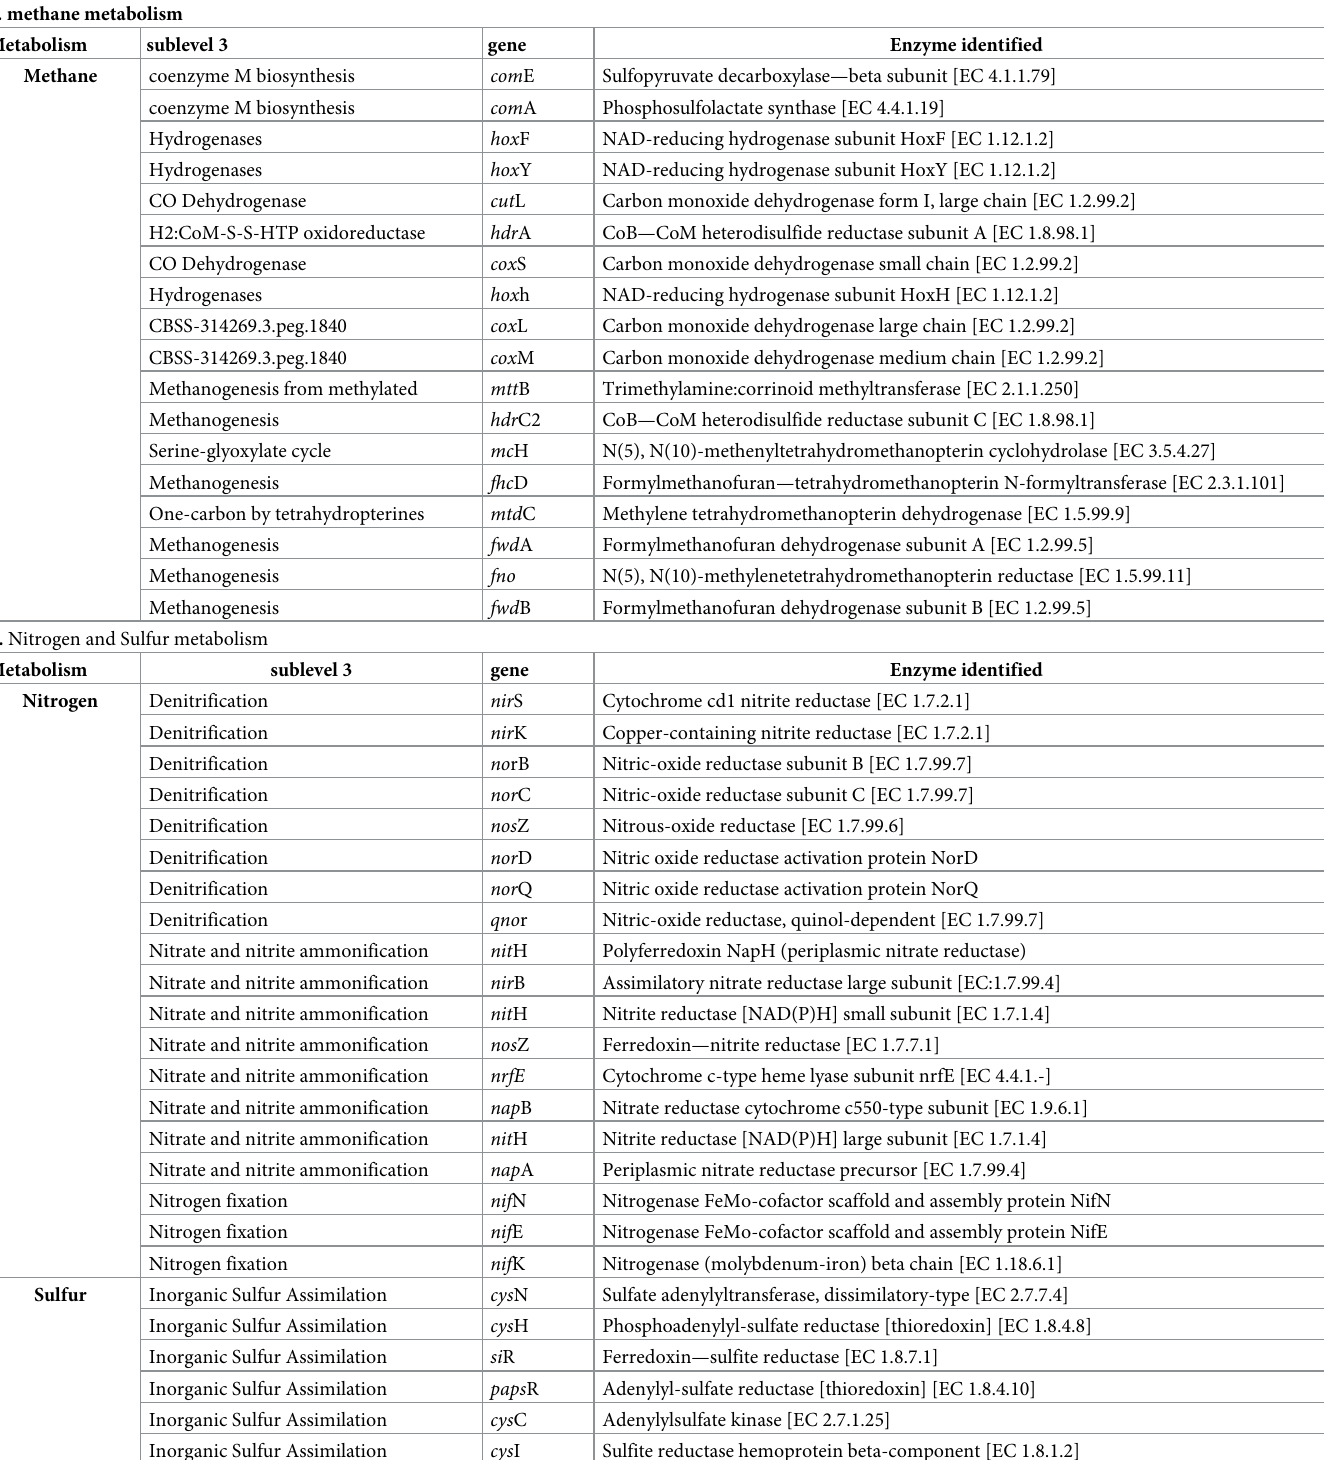
Table 3. Annotated gene and enzyme identified in metagenome MGB-2 and